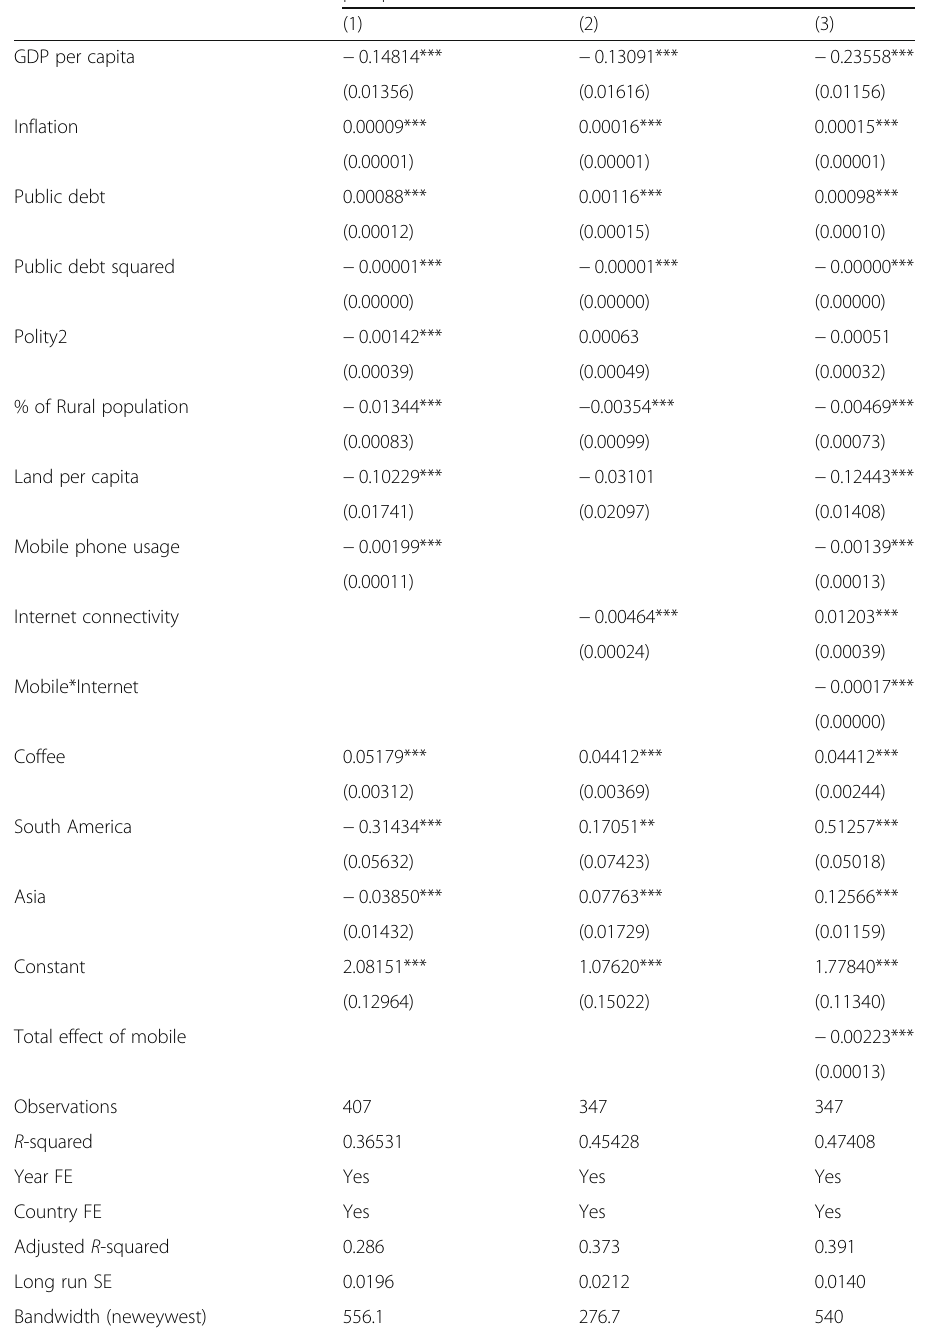
Table 2 Determinants of absolute nominal rate of